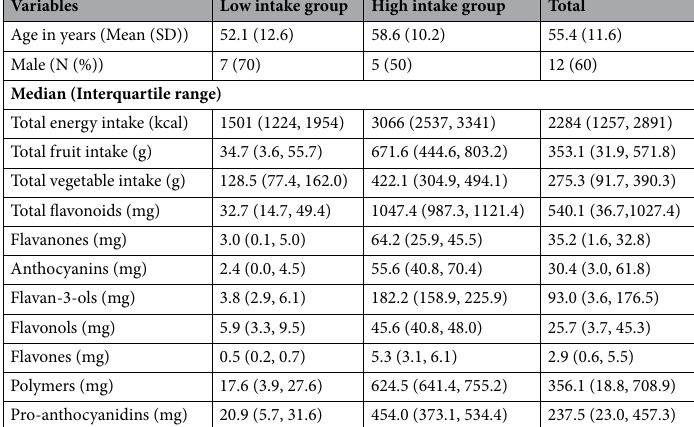
Statistical analysis. Predicted dietary intake of total flavonoids, flavonols, flavan-3-ols, flavones, fla-